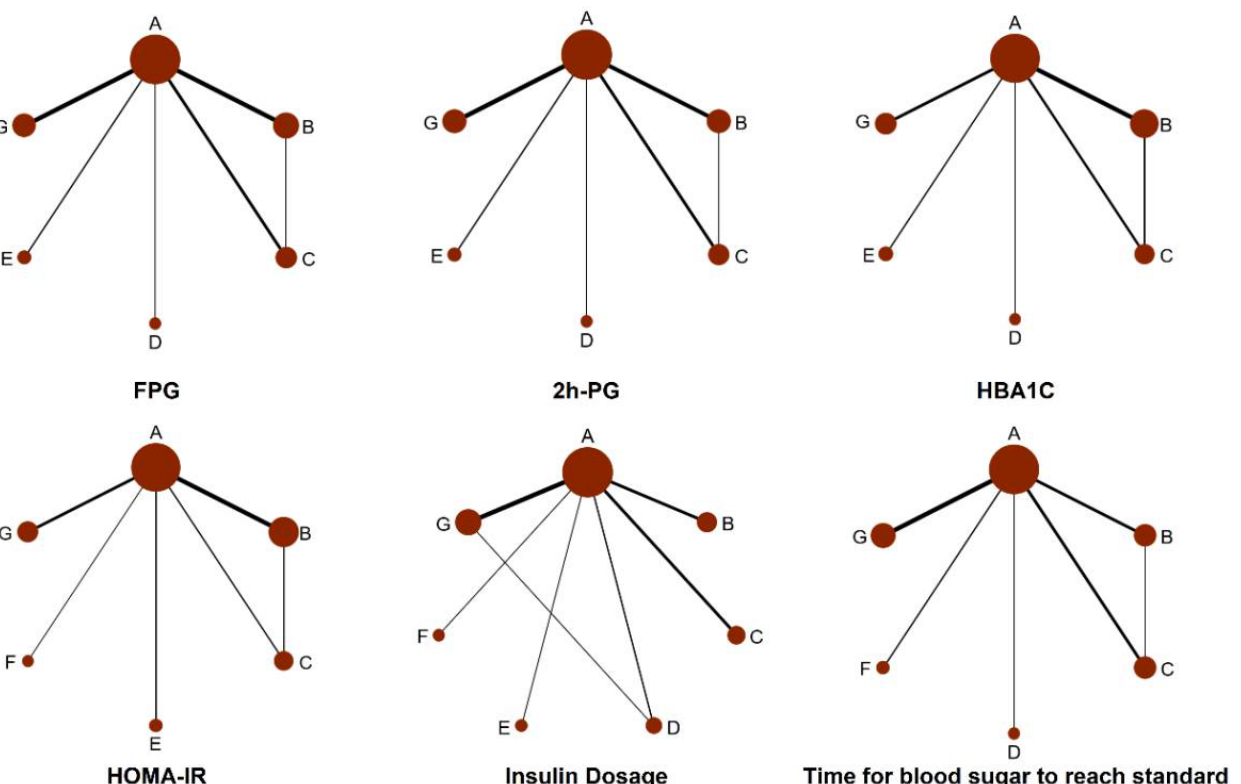
Figure 4. Network plots of different outcomes and direct/indirect comparisons in the network meta- analysis. Figure note: The network diagram shows direct and indirect comparisons between studies. The connection lines represent evidence of direct comparison between the two linked interventions. The two interventions without wires can be compared indirectly using a network meta-analysis. The size of the point represents the sample size of a treatment. The thickness of the line represents the number of studies compared using the two methods. Treatments of the various groups: A: